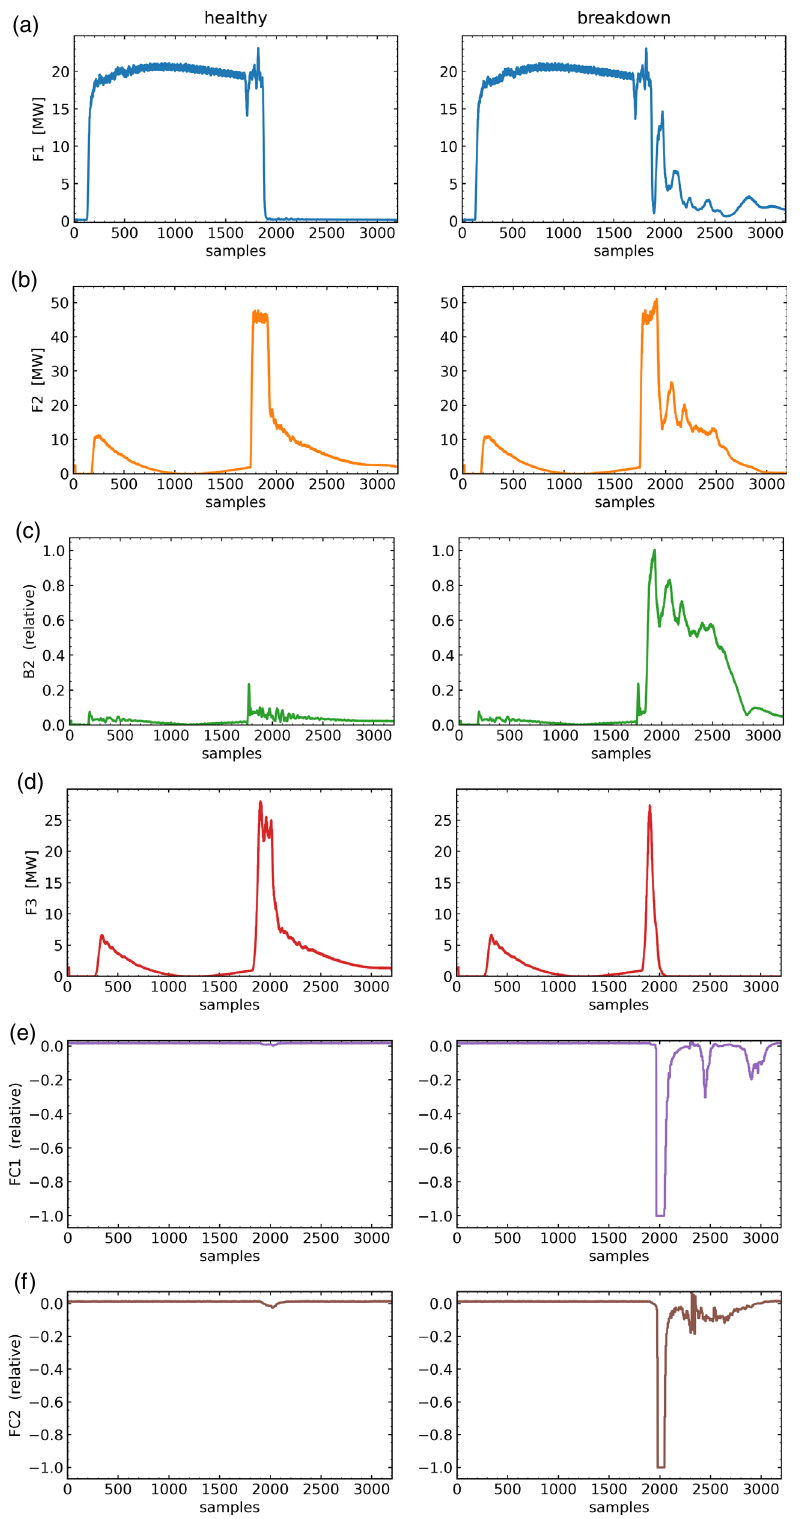
FIG. 3. Two examples of different events, showing the F1, F2, B2, F3, FC1, and FC2 signals. The left plots represent the signals of a healthy event, the right plots represent the signals of a breakdown event. All signals are 2 μ s long. Note that the power amplitude of the forward traveling waves after the klystron (a), before the structure (b), and after the structure (d), are shown in MW. The power amplitude in the backward traveling wave (c), the upstream (e), and downstream (f) Faraday cup signals are shown relative to their maximum value, as no calibration coefficients were provided by the